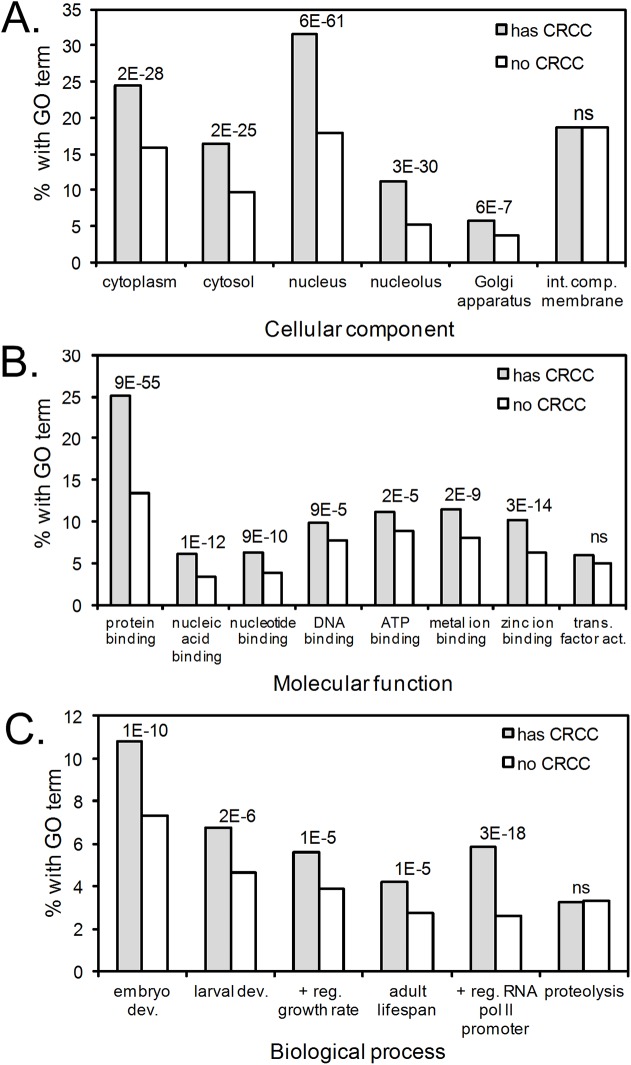
Homolog families with CRCCs are significantly enriched (p-value ≤ 0.0001) in certain gene ontology (GO) terms, including (A) cytosolic and nuclear localized proteins, (B) functions associated with binding, and (C) processes associated with growth and development. GO categories analyzed were the 10 most common GO terms in each GO term class (cellular component, molecular function, and biological process). The y-axis indicates the percentage of homolog families (with or without CRCC) that were assigned a particular GO term. Because the same homolog family may be assigned more than one GO term, bars will not necessarily sum to 100%. The right-most bars in each panel are included as examples of GO terms not significantly enriched in homolog families with CRCCs. No GO terms were significantly under-enriched in homolog families with CRCCs.